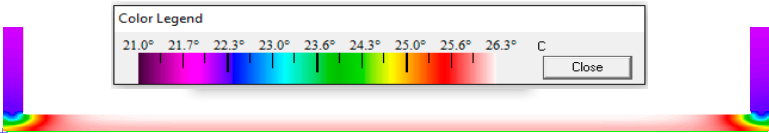
Figure 4. Temperature distribution along the façade surface of the mullion and the shadow box of the curtain wall.